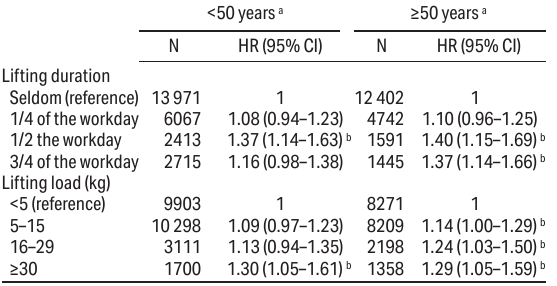
a Analyses are adjusted for sex, age, year of questionnaire reply, education, use of assistive devices, BMI, leisure-time physical activity, smoking, job strain, influence at work, and depressive symptoms. b Significant difference.